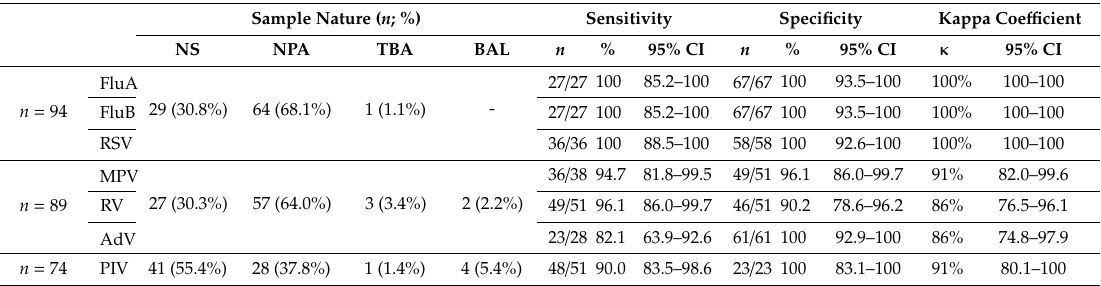
Clinical sensitivity and specificity of Panther Fusion respiratory panels for the retrospective